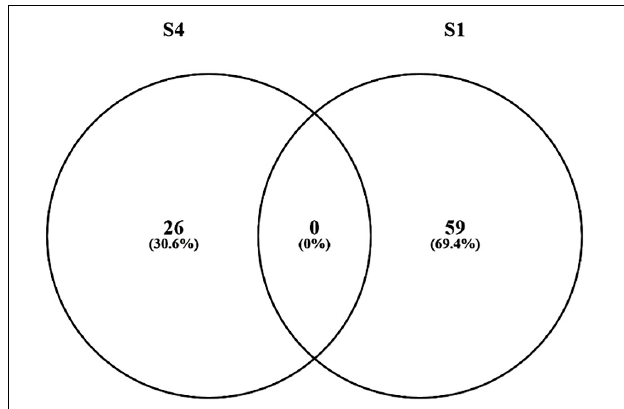
FIGURE 10 | Diets induce changes in gene expression in ballan wrasse intestine. The figure shows the Venn diagram of the DE genes in Segment 1 (S1) and Segment 4 (S4) in the two treatments (moist and dry diets).